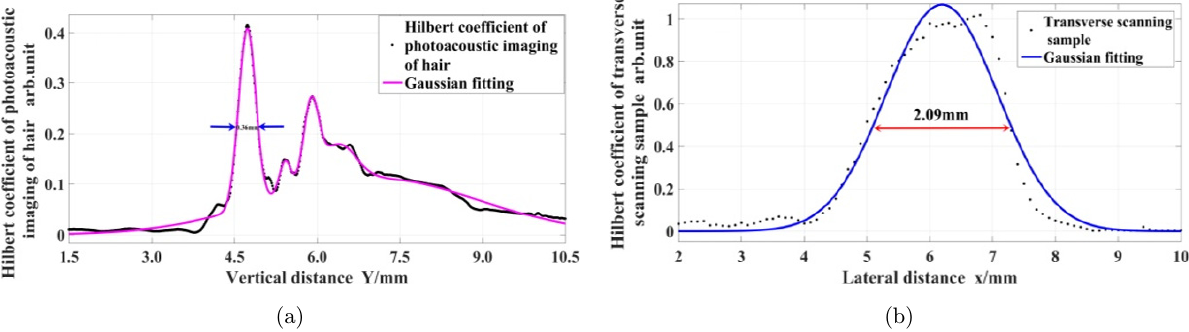
Fig. 4. The resolutions of scanning photoacoustic tomography system. (a) Longitudinal resolution; (b) Transverse resolution. Table 1. Absorption coe±cient and reduced scattering coe±cient of simulated absorbers (1) – (6) at 808 nm laser in K-M theory. Absorber Volume of ink V/ml Thinkness d/mm Absorption coe±cient (cid:3) a /mm (cid:1) 1